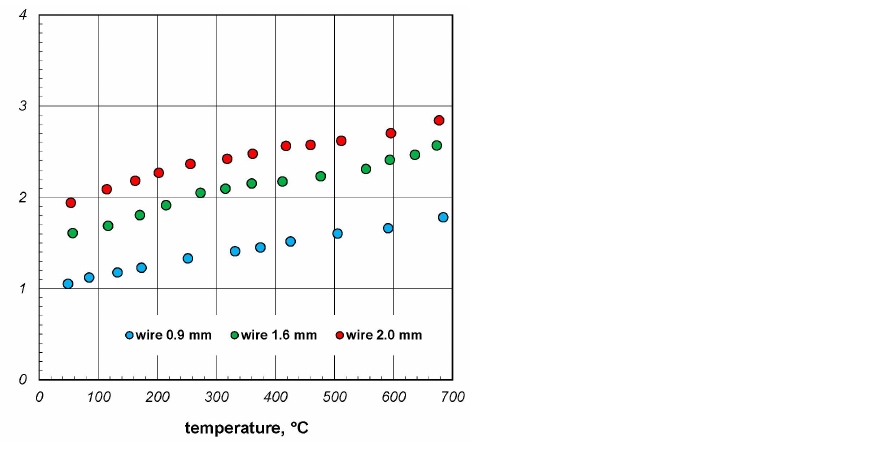
Figure 5. The effective thermal conductivity of the wire coil samples depending on the temperature and wire diameter.